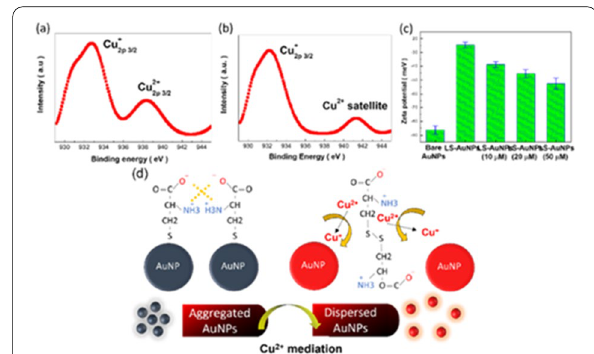
Fig. 3 XPS results of LS‑AuNP probes for detecting Cu 2 + ions: a 20 μM and b 50 μM. c Zeta potentials of different LS‑AuNP samples. d Schematic illustration for detecting Cu 2 +